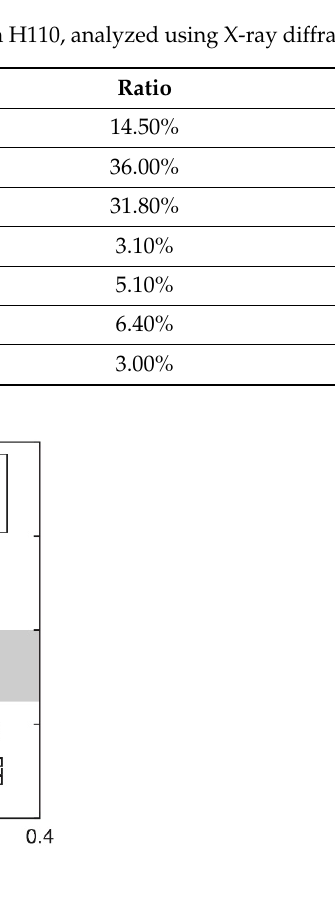
Figure 11. Projection of the low-velocity range below H110 onto the classical statistics [26] of velocity versus porosity in water-saturated sandstones. Curves I and II are based on equations for unconsolidated [27] and consolidated sandstones [28], while III is for quartz-calcite rocks [29].